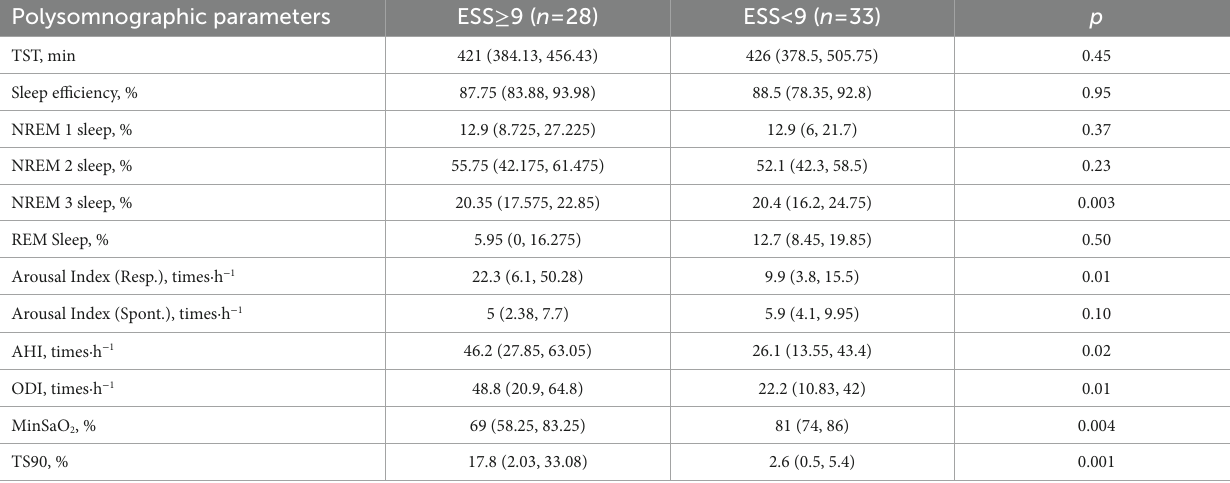
TABLE 2 Polysomnographic parameters of OSA patients.